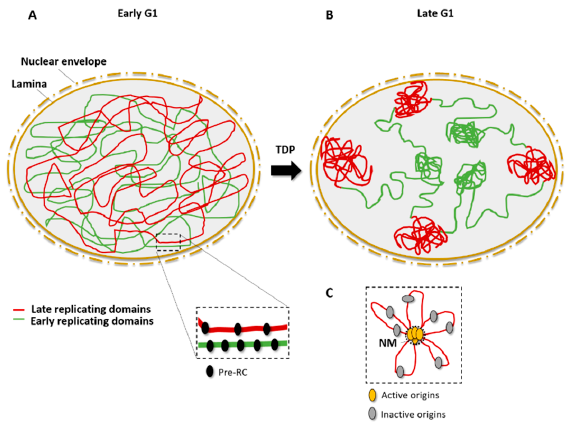
Figure 2. Spatial organization of origins and replication timing. ( A ) In the early G1 phase, Pre-RCs (black) are assembled on the chromatin and mark potential origins; early-replicating domains (green) and late-replicating domains (red) are disordered in the nuclear space. ( B ) After the timing decision point (TDP), in the late G1 phase, early-replicating domains are close to center of the nucleus whereas late-replication domains are associated with the lamina, close to the nuclear periphery. ( C ) Active origins (yellow) cluster in replication domains that are associated to the nuclear matrix (NM), leaving inactive (dormant or flexible) origins in DNA loops (gray).